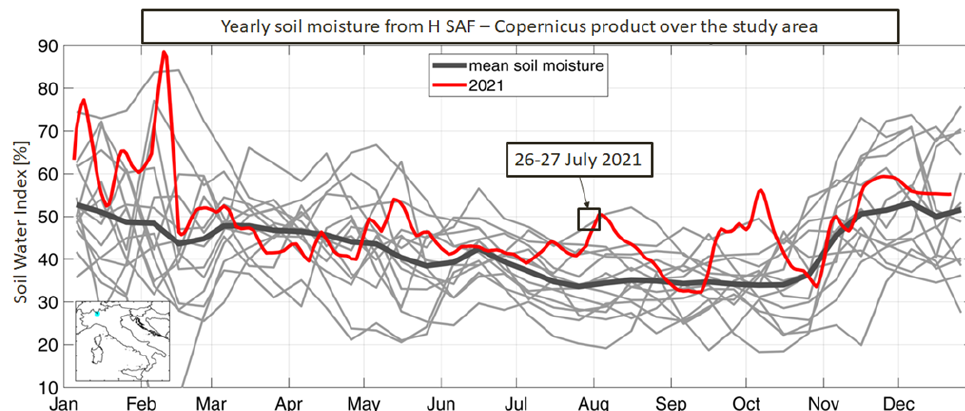
Figure 2. Soil moisture (ASCAT Soil Water Index).